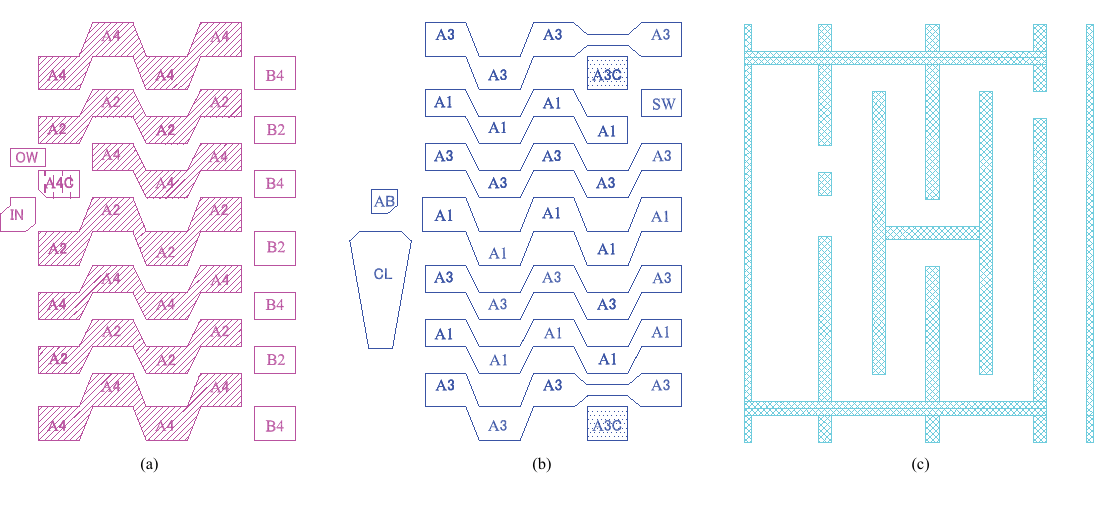
Figure 9. Layouts of a four-phase CCD-ISAS of: (a) the first polysilicon layer; (b) the second polysilicon layer; (c) the channel stoppers. For abbreviations, see Appendix